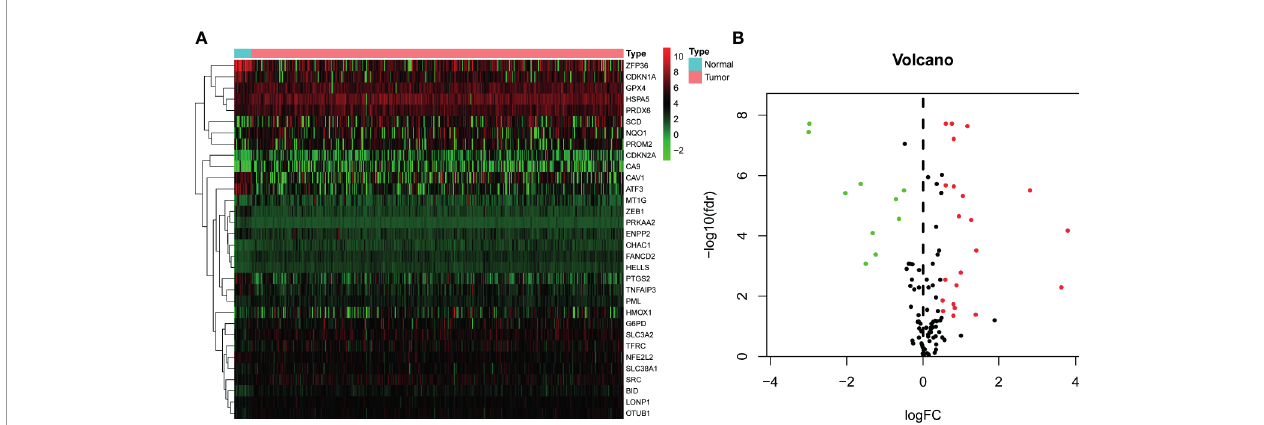
FIGURE 1 | Identi fi cation of differentially expressed FRGs in TCGA – BLCA cohort. (A) Heatmap of FRGs. Green represents downregulation, and red represents upregulation of genes. (B) Volcano plot of FRGs. Green dots represent 10 downregulated genes; red dots represent 22 upregulated genes. FRG, ferroptosis − related gene; TCGA, The Cancer Genome Atlas; BLCA, bladder cancer.